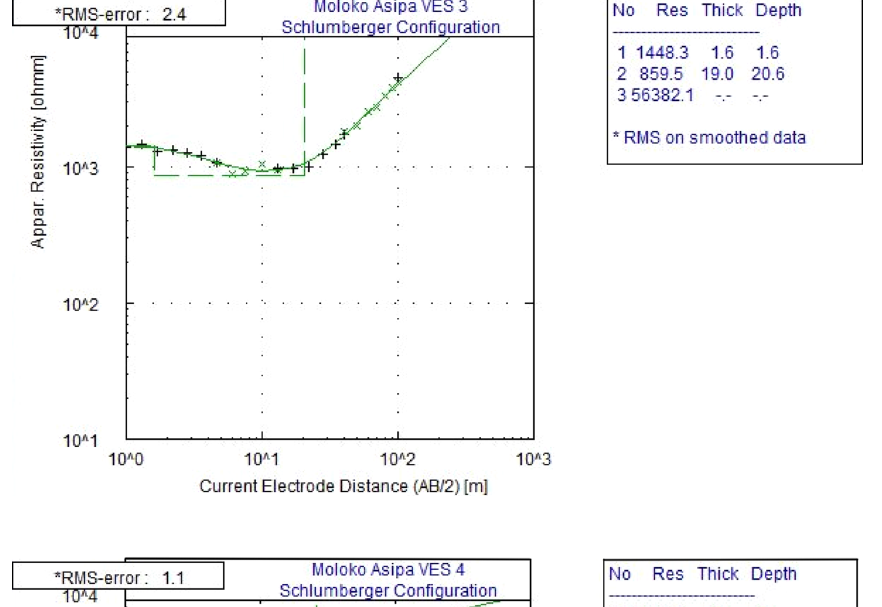
Fig. 13 Layer model interpreta- tion for VES